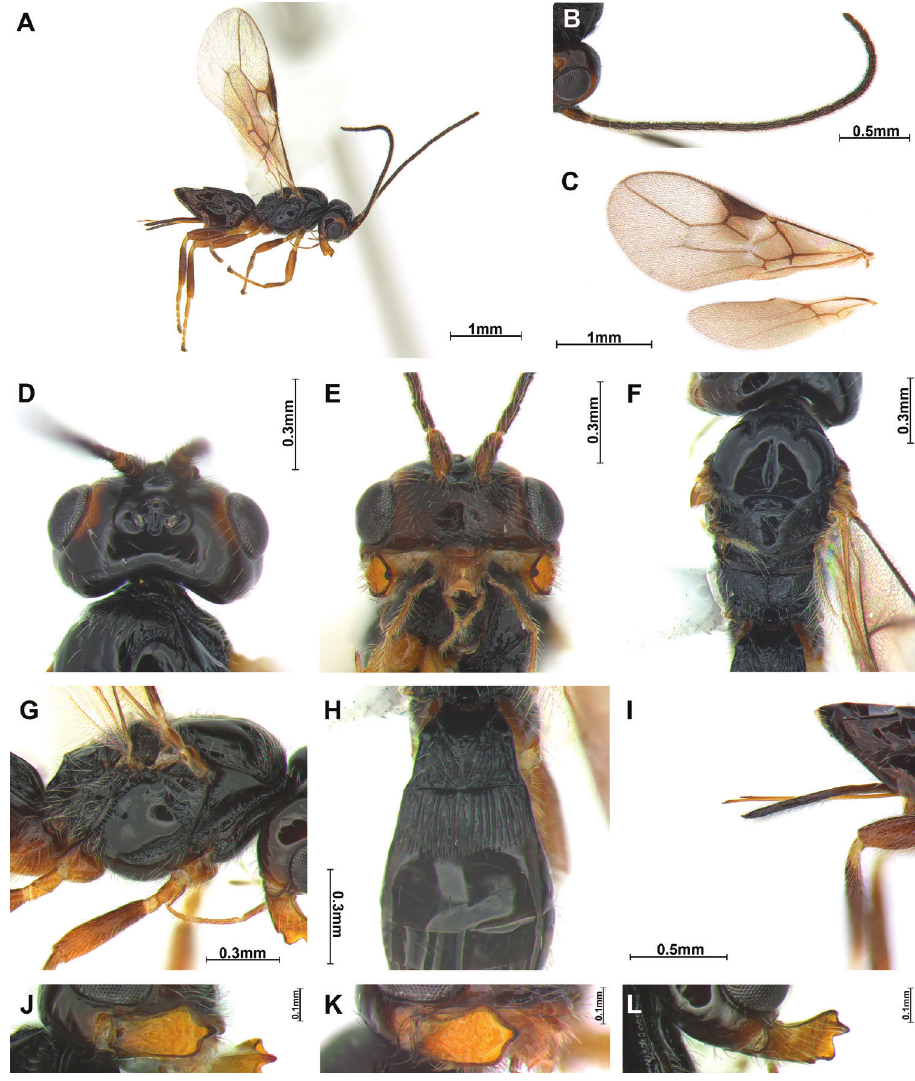
Figure 1. Separatatus megagnathus sp. nov., ♀ A habitus, lateral view B antennae C wings D head, dorsal view E head, front view F mesosoma, dorsal view G mesosoma, lateral view H anterior half of metasoma, dorsal view I ovipositor sheath, lateral view J mandible, lateral view K mandible, antero-lateral view L mandible with teeth. Scale bars: 1 mm ( A, C ); 0.5 mm ( B, I ); 0.3 mm ( D–H ); 0.1 mm( J–L 1-SR+M slightly bent; vein 2-SR+M and r-m not sclerotized; vein r-m inclivous; vein 2-SR:vein r:vein 3-SR = 10:3:11; first subdiscal cell of fore wing 2.5 times longer than wide medially; vein m-cu distinctly postfurcal. Hind wing 4.1 times longer than wide; vein M+CU slightly bent; vein M+CU:1-M:1r-m = 11:6:3. Legs . Hind coxa smooth and 1.1 times longer than trochanter; hind femur 0.8 times as long as hind tibia and